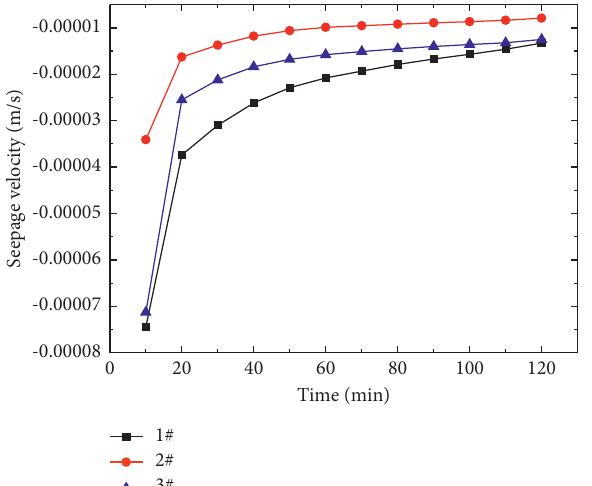
Figure 20: Infiltration velocity at observation points 1–3 of building 1 without seepage wells around buildings in the numerical